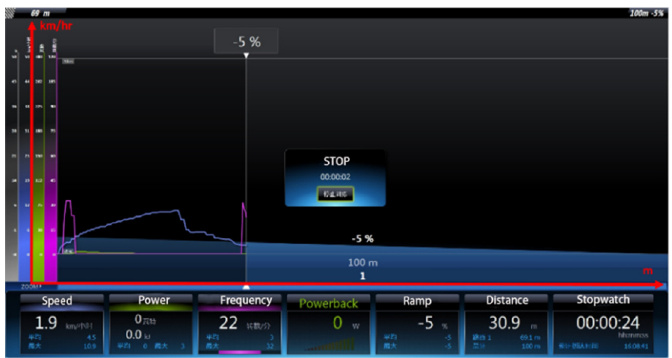
Figure 15. Results for road slope − 5%, cyclist weight 40 kg, and lower-arm three-phase short-circuit braking.